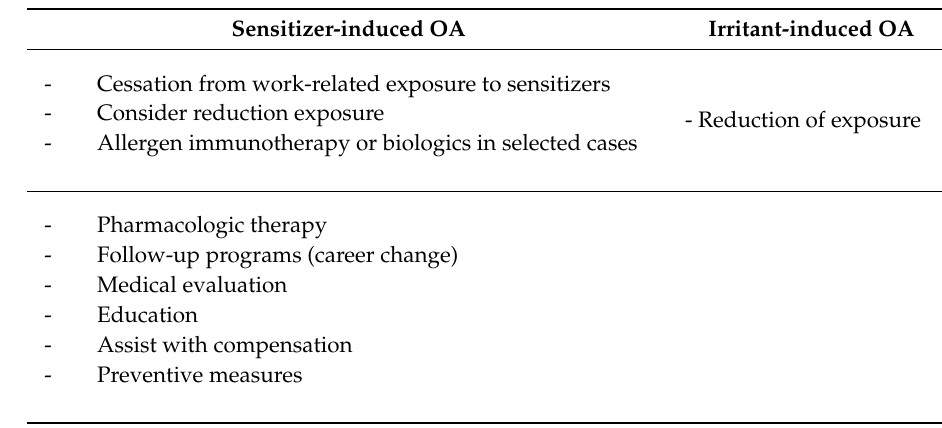
Table 2. Management of